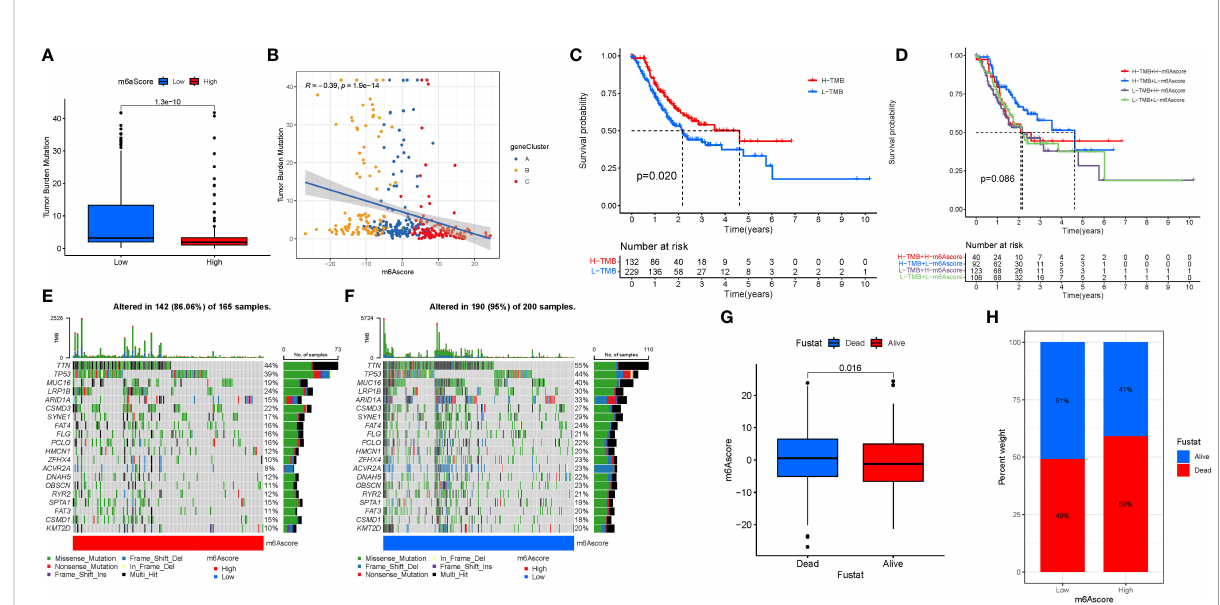
FIGURE 8 TMB Score Construction. (A) TMB of m6Ascore.group. (B) Tumor Burden Mutation with m6Ascore. (C) TMB.survival. (D) TMB-score.survival. (E) High mutations. (F) Low mutations. (G, H) Survival